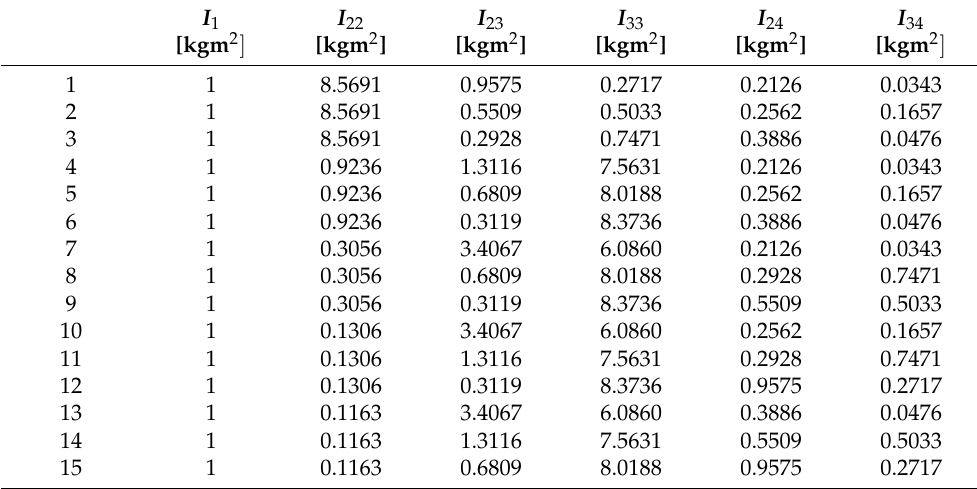
Table 1. Parameters of inertial